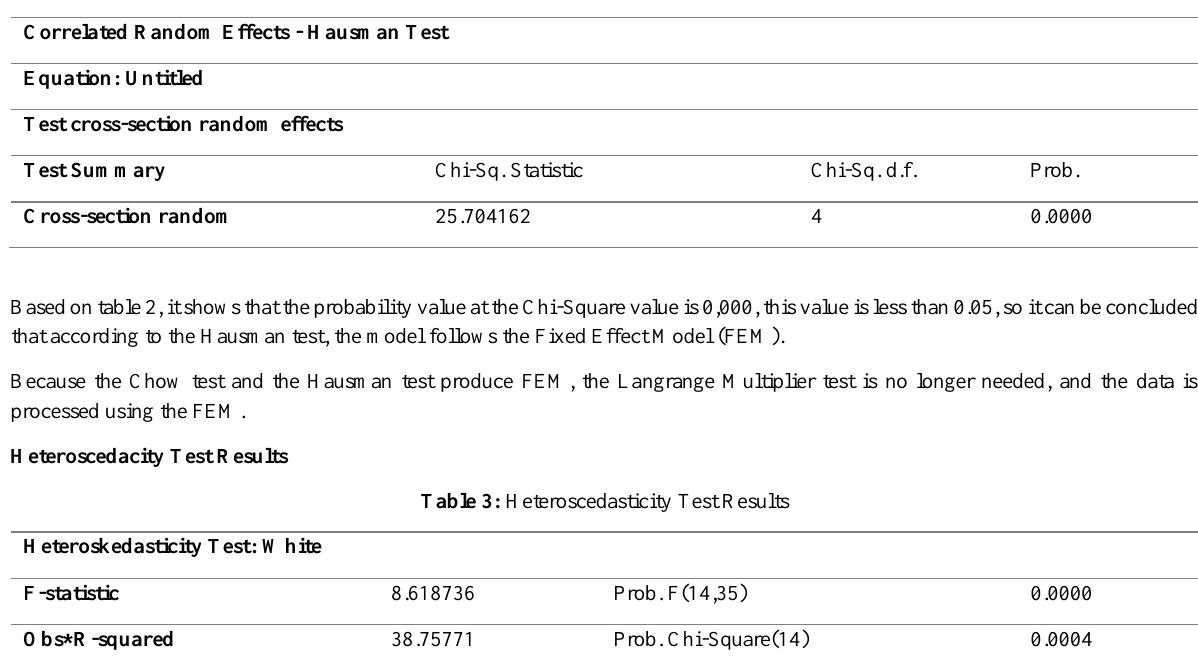
Table 2: Hausman Test Results